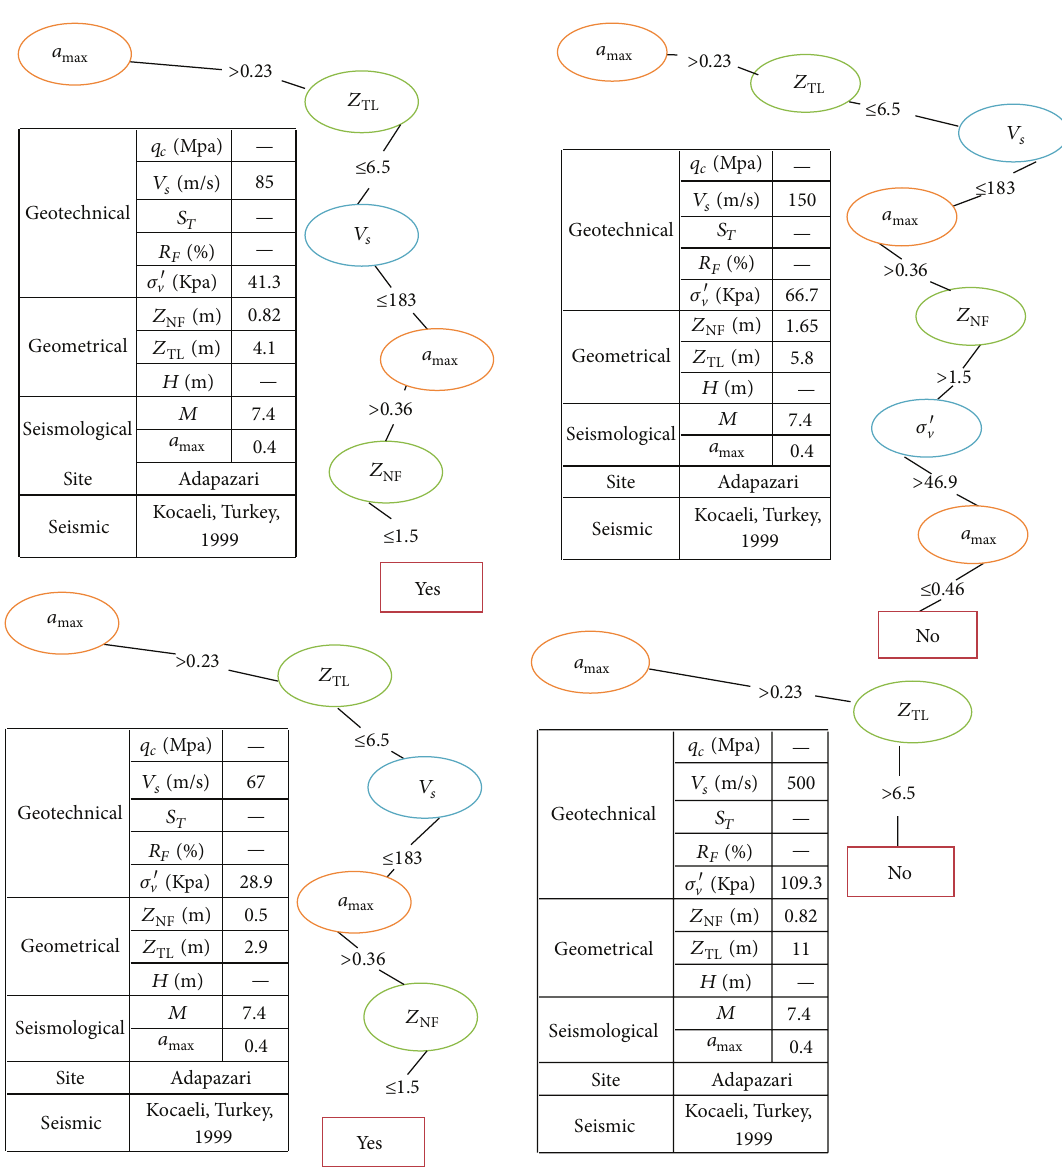
Figure 26: CLIP results for Kocaeli, Turkey, earthquake.